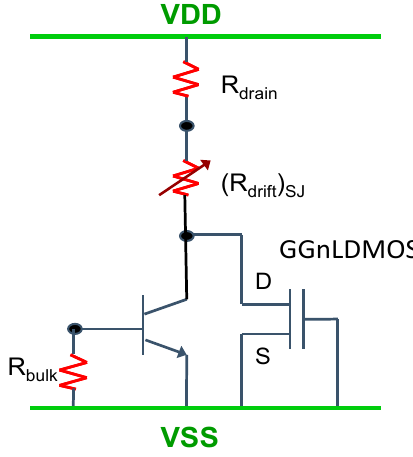
Figure 5. An equivalent circuit of a GGnLDMOS device with symmetrical SJs in the drain region.